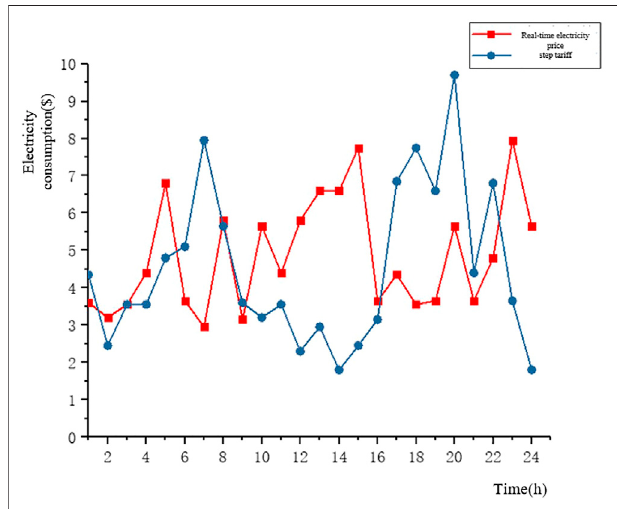
FIGURE 7 | Comparison of daily electricity consumption between consumers ’ real-time electricity price and step